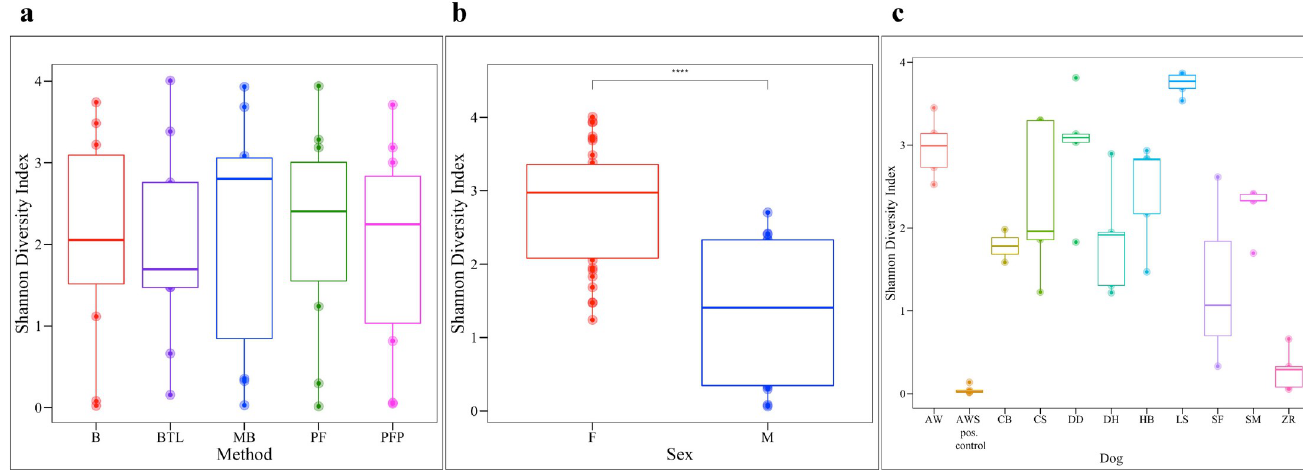
Fig 3. Bacterial diversity. The Shannon diversity metric was used to compare bacterial diversity by ( a ) extraction method, ( b ) sex, ( c ) and dog. Bacterial diversity did not differ significantly by kit (Kruskal-Wallis, p = 0.951) but did differ significantly by dog (Kruskal-Wallis, p = < 0.001). For all statistically significant pairwise comparisons by dog, see S6 Table . Females exhibited higher bacterial diversity than males (Kruskal-Wallis, p = < 0.001). B = Bacteremia, BTL = Blood & Tissue with Lysozyme, MB = Magnetic Beads, PF = PowerFecal 1 , PFP = PowerFecal 1 Pro, F = Female, M = Male. https://doi.org/10.1371/journal.pone.0253989.g003 PLOS ONE | https://doi.org/10.1371/journal.pone.0253989 July 9,